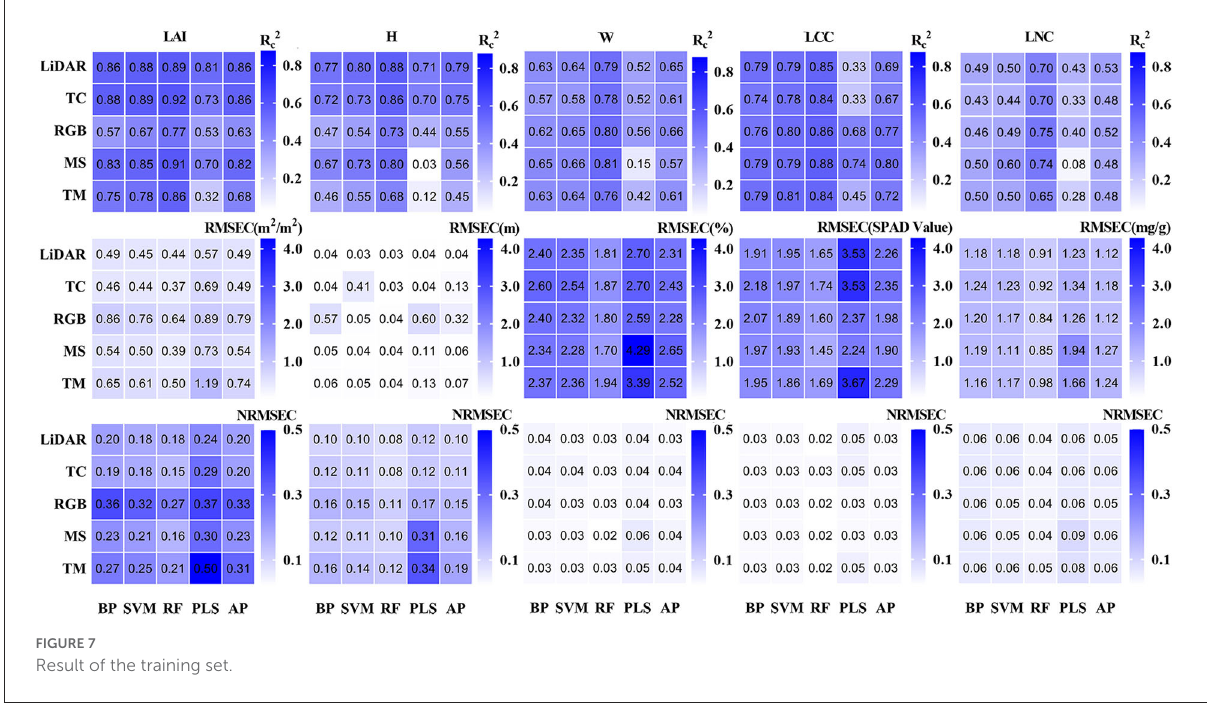
FIGURE7 Result of the training set.